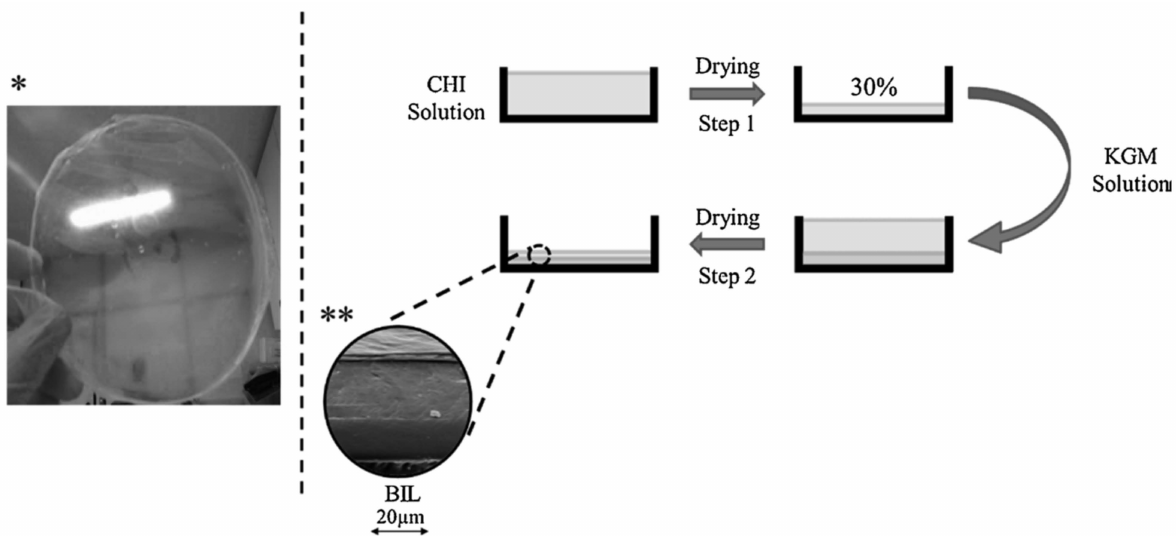
Figure 4. Picturized representation of the Two-step casting process used for the production of bilayer films; * Digital image of the prepared bilayer film; ** shows the SEM image of the bilayer film. (Reproduced with permission from [44] Copyright